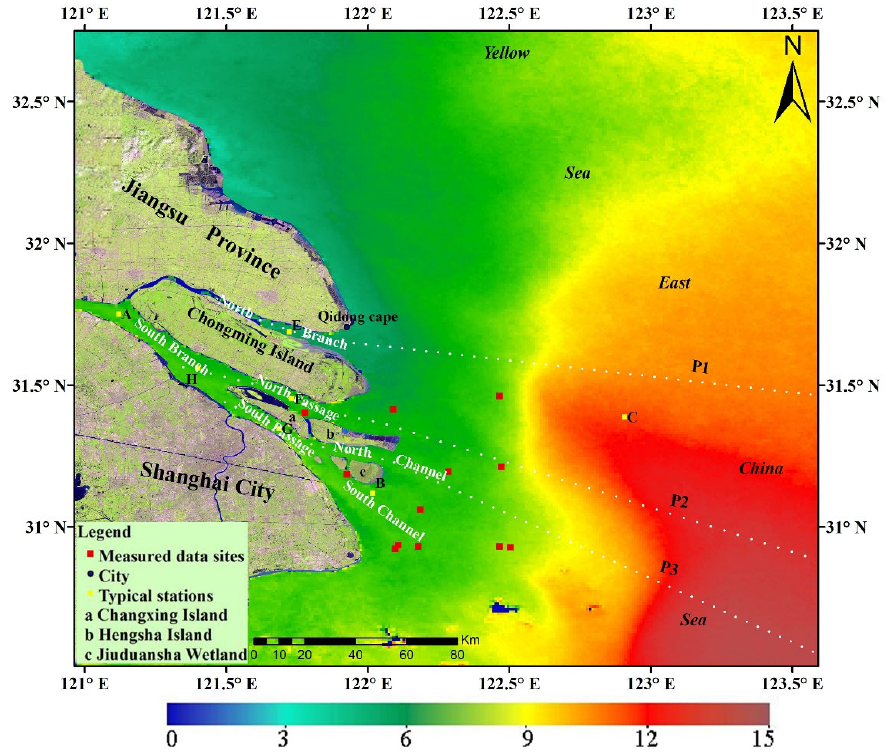
Figure 1. Multi ‐ year mean SST in the Yangtze Estuary in January and sample sites, stations, and profiles (sites A (31.75° N, 121.12° E), B (31.06° N, 122.05° E), and C (31.38° N, 122.92° E), representing inside the mouth, the mouth opening and outside the mouth of the Yangtze Estuary, respectively. E (31.69° N,121.7° E), F (31.45° N, 121.73° E), G (31.35° N, 121.69° E), and H (31.55° N,121.38° E) represent the North Branch, South Branch, North Passage, and South Passage, respectively. The SST at each reference location is represented by the average of the SST of 2 × 2 total of four pixels at that location. P1, P2, and P3 are the profiles of SST from inside the mouth to outside the mouth derived from a two ‐ dimensional model using an orthogonal curve grid). Additional SST data were collected from NASA’s Ocean Biology Processing Group (OBPG)’s SeaBASS (https://seabass.gsfc.nasa.gov/search/sst, accessed on 27 November 2022), which is a publicly accessible ocean and atmospheric real ‐ world data platform. The platform includes data collected in situ within 30 min of satellite transit, with a product image within 10 km; the majority of these data are measurements collected by ships, NOAA’s in situ SST quality monitor Quam, and shipboard marine atmospheric emitted radiance interferometers (M ‐ AERIs). 2.4. Construction of the SST Inversion Algorithm This algorithm utilizes the different absorption properties of adjacent thermal infra ‐ red channels in the atmospheric window (11–13 m) to eliminate atmospheric influences and to obtain an inversion of the SST by linearly combining the brightness temperatures of the two channels [17]. In addition, using this algorithm, any interference produced by atmospheric thermal radiation on water vapor absorption can be decreased, and the prob ‐ lem of high atmospheric water vapor content in nearshore waters can be addressed. Fur ‐ thermore, this algorithm can fully account for the parameters of bright temperature, at ‐ mospheric transmission, and specific emissivity, as well as various subsurface properties, with a simple and accurate model [23]. In this study, we present a high ‐ precision algo ‐ rithm based on Qin’s algorithm [42] that accounts for the characteristics of the water